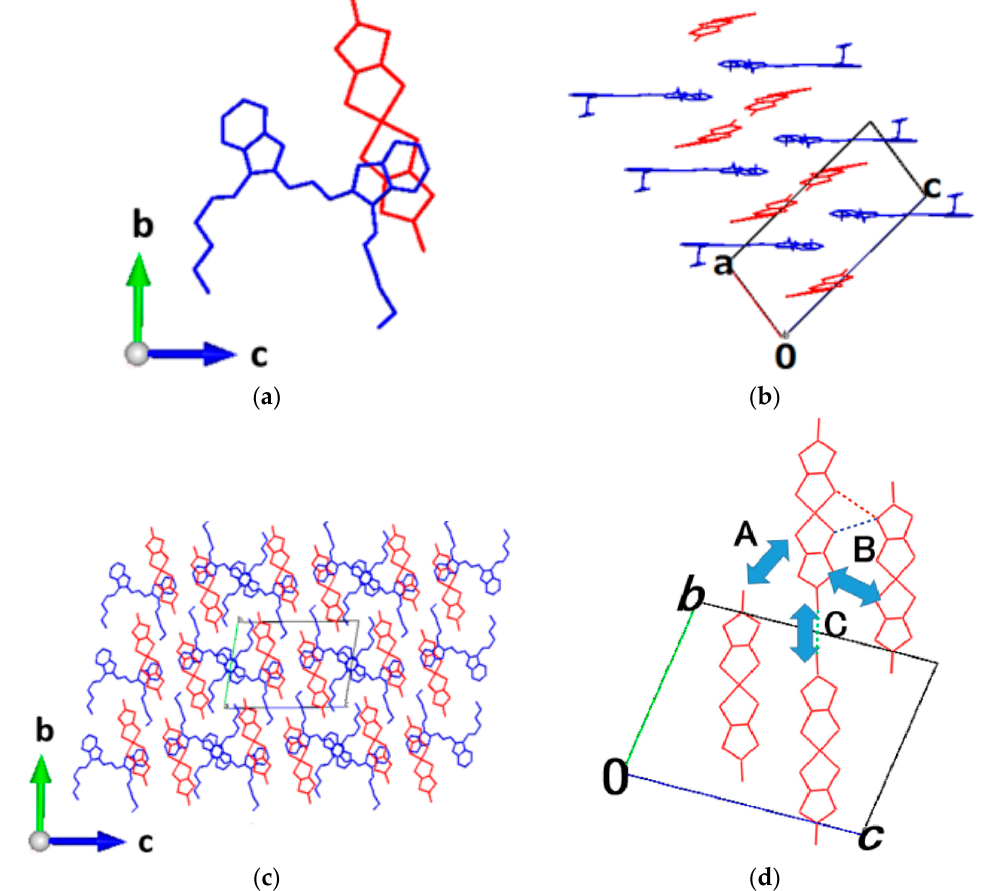
Figure 1. Crystal structure of γ‐ DiCC[Ni(dmit) 2 ] (DiCC = 3,3 ′‐ Dihexyloxacarbocyanine monocation). Red; Ni(dmit) 2 anon, blue; DiCC cation, hydrogen atoms are omitted for clarity: ( a ) asymmetric unit; ( b ) view down along b ‐ axis; ( c ) view down along a ‐ axis; ( d ) interaction between anions in the bc ‐ plane. In ( d ), the shortest sulfur–sulfur distances between the two anions designated by broken lines are 3.280(2) (green, in relation C), 3.572(2) (blue, B), 3.705(2) Å (red, B), respectively.